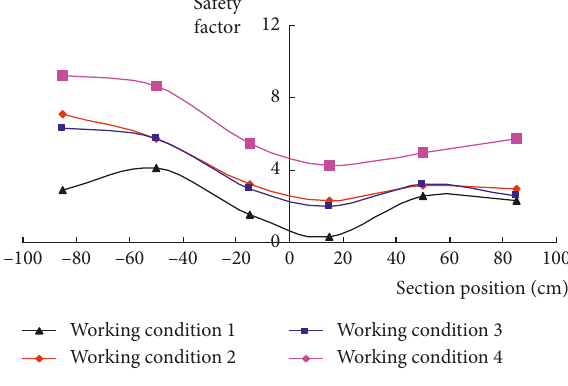
Figure 9: Safety factor of the tunnel Table 8: Increasing multiple of the minimum value of the safety factor.